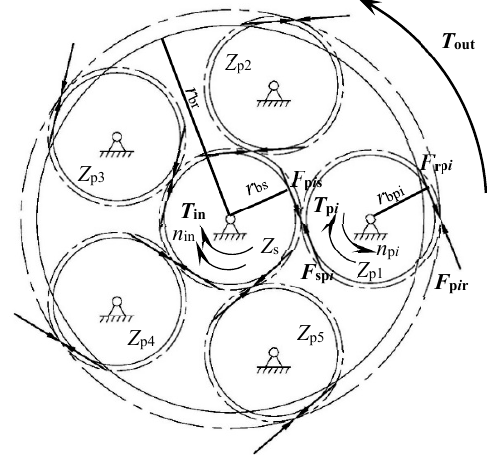
Figure 4. Force analysis of gear trains.